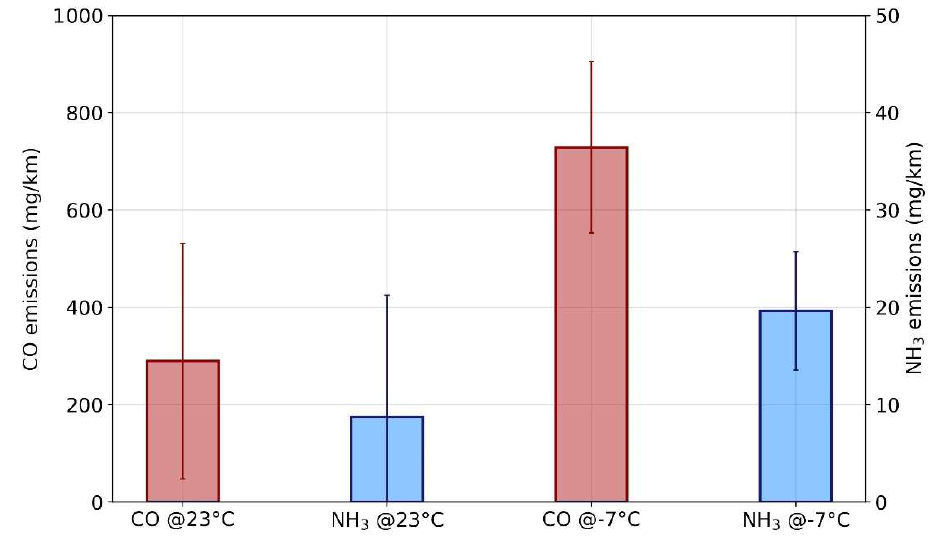
Figure 2. Bar plots of average NH 3 and CO emissions emitted by fifteen vehicles on the WLTC, at 23 °C and at −7 °C. Error bars correspond to standard deviation.